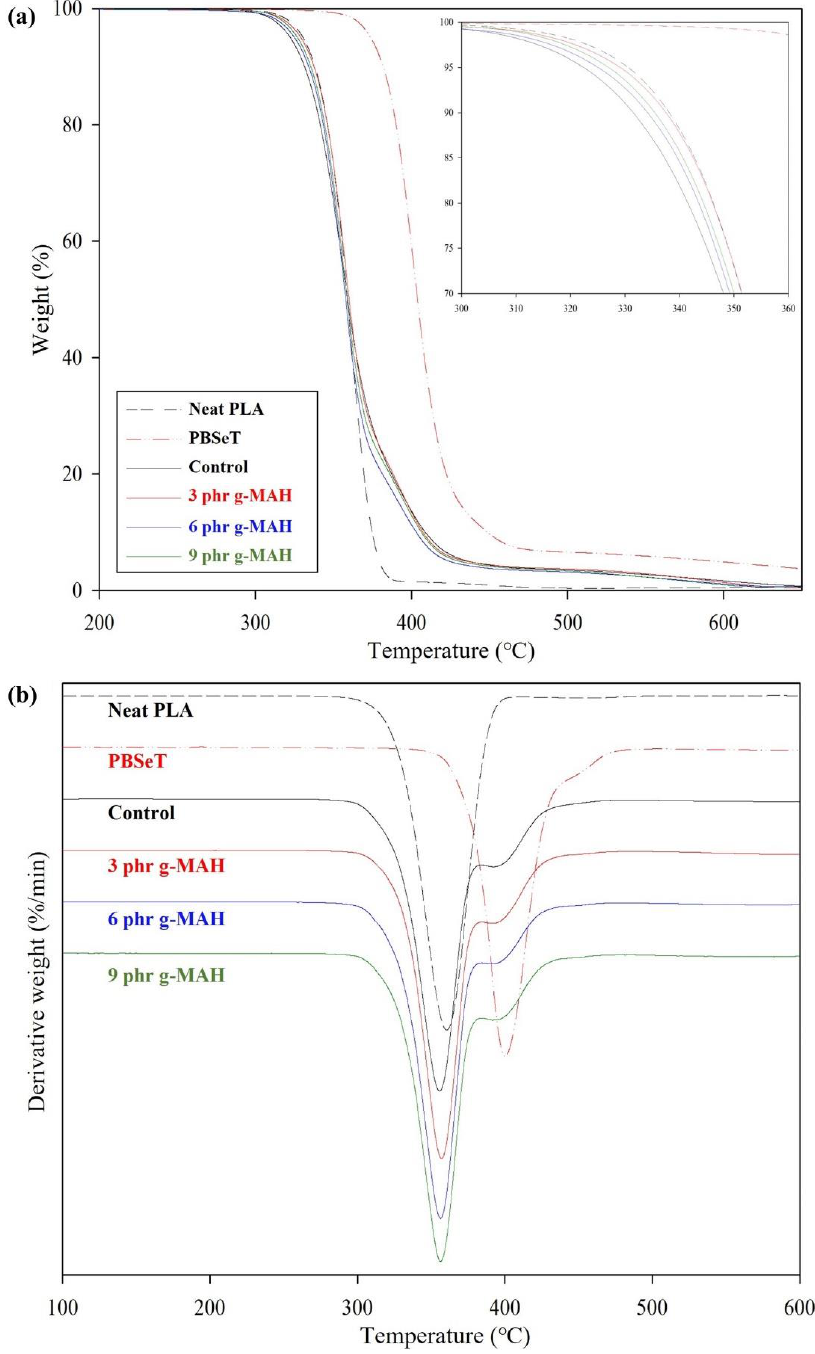
Figure 6. ( a ) TGA and ( b ) DTG thermograms of neat PLA, neat PBSeT, and PLA/PBSeT blends without PLA-g-MAH (control) and with various PLA-g-MAH contents.